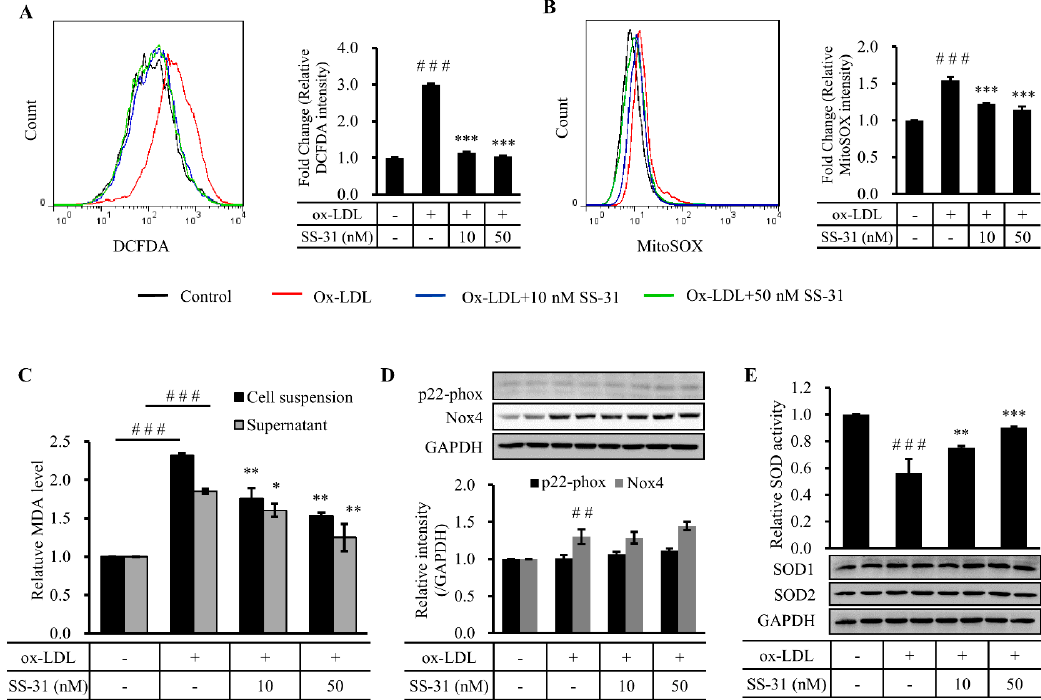
Figure 2. SS-31 suppresses ox-LDL-induced oxidative stress in RAW264.7 cells. ( A ) Representative fluorescence-activated cell sorter (FACS) analysis with a free radical sensor H 2 DCFDA (left panel) and relative mean fluorescence intensity of H 2 DCFDA (right panel) indicates intracellular ROS production. Cells were treated the same as in Figure 1 before treatment of H 2 DCFDA; ( B ) Representative FACS analysis with MitoSOX Red, a mitochondrial O 2 − specific dye, (left panel) and relative mean fluorescence intensity (right panel) indicates mitochondrial ROS production; ( C ) Levels of cell suspension and medium supernatant MDA content; ( D ) A representative Western result (upper panel) and quantitative data (lower panel) of the expression of p22-phox (Nox2) and Nox4 after ox-LDL and/or SS-31 treatment; ( E ) Enzymatic activity of SOD (upper panel in bar graph) and a representative Western blot analysis of SOD1/2 expression (lower panel). GAPDH was used as a loading control. All quantitative data are from four independent experiments. ### p < 0.001 compared with the control group, ## p < 0.01 compared with the control group. *** p < 0.001 compared with the ox-LDL group, ** p < 0.01 compared with the ox-LDL group, * p < 0.05 compared with the ox-LDL group. ROS: reactive oxidative species;